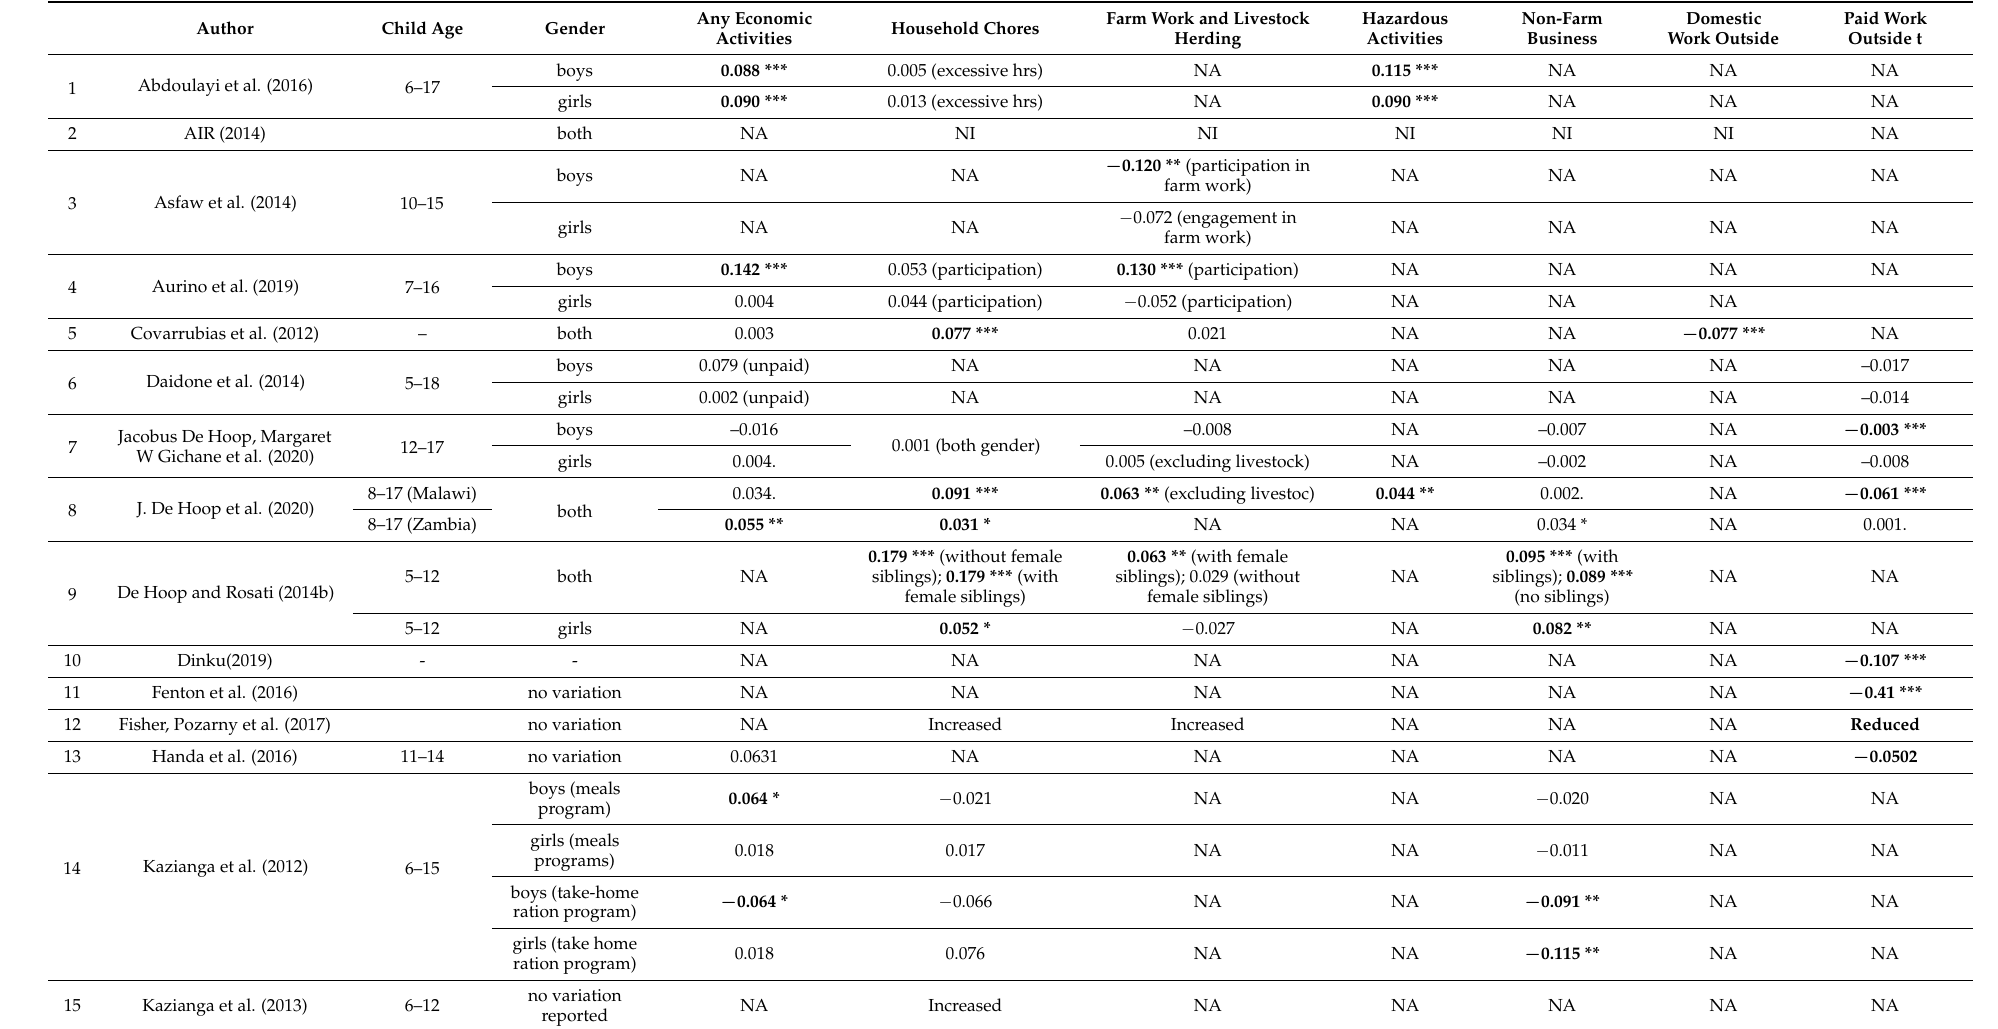
Table 3. Specific Outcome of Social Transfer on Forms of Child Labour and